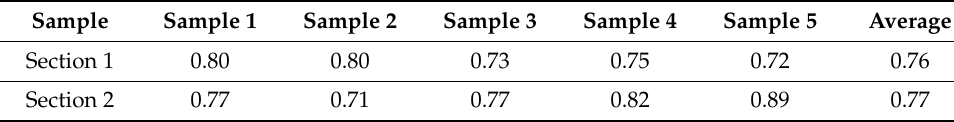
Table 2. Measured radial effective thermal conductivity.